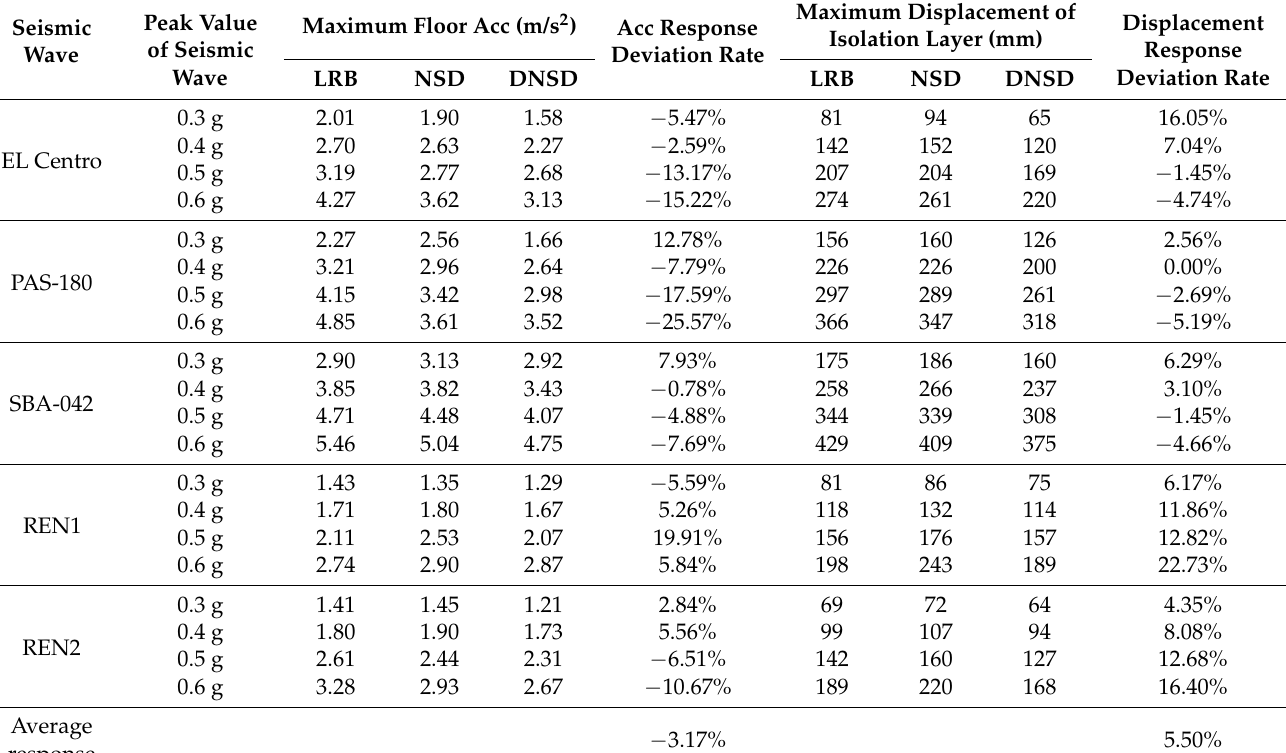
Table 4. Summary of time history results under the action of local seismic waves (LRB vs.